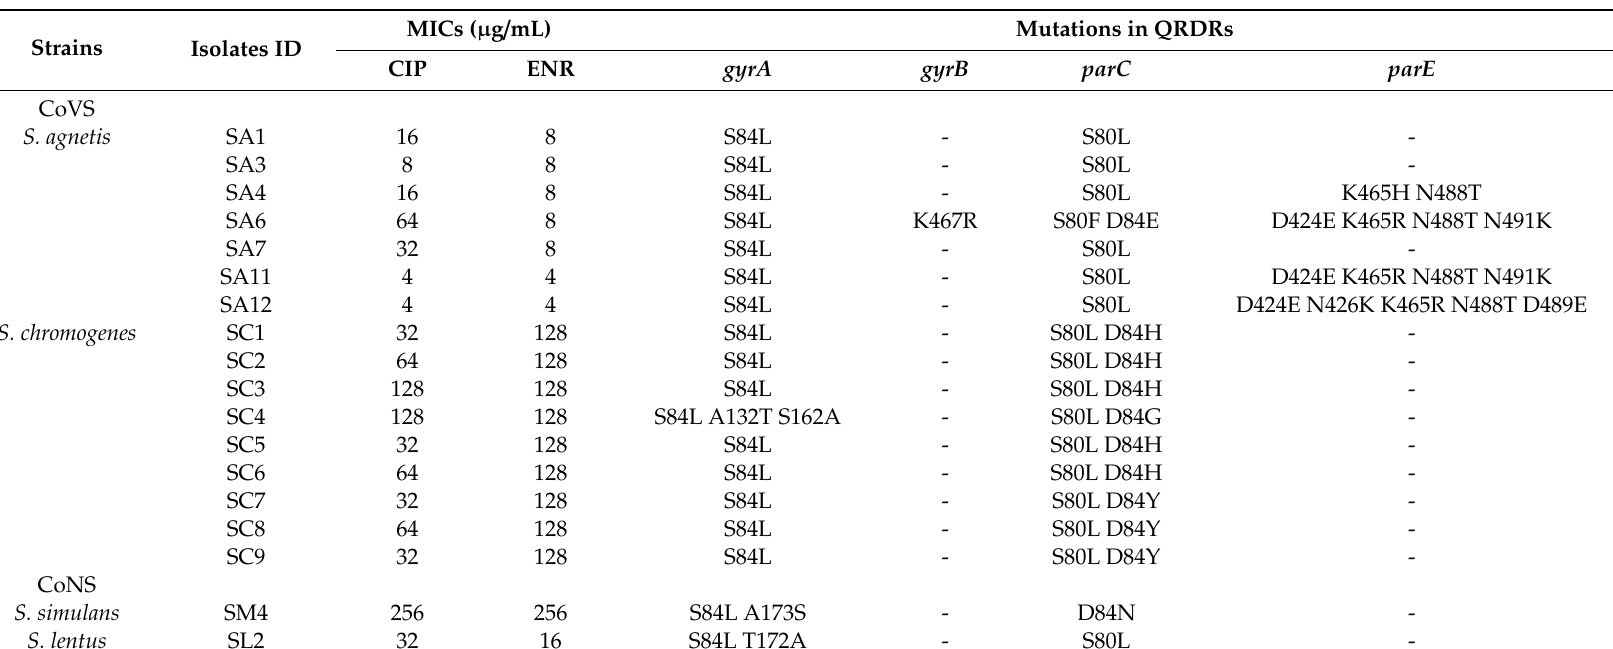
Table 4. Mutations in the quinolone resistance determining regions (QRDRs) of gyrA , gyrB , parC , and parE in fluoroquinolone-resistant non- aureus staphylococci (NAS) isolated from retail chicken